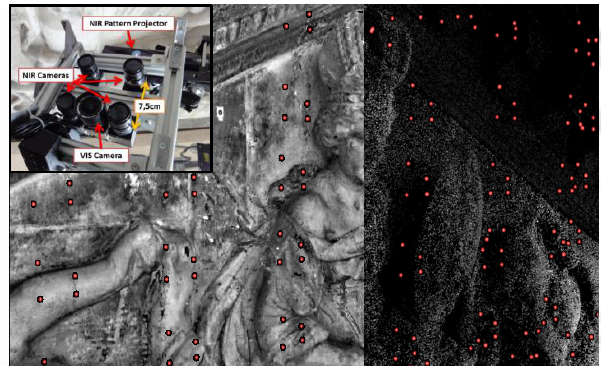
Figure 3: Image based data acquisition of cultural heritage objects at short distance. Sub-mm resolution and accuracy by using multi-camera solutions at an acquisition distance of 0.5-1m. Red dots: camera stations, right: sparse point cloud, left: dense point